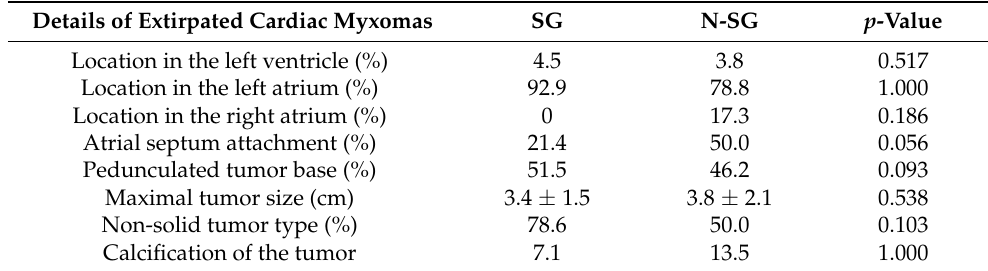
Table 6. Details of extirpated cardiac